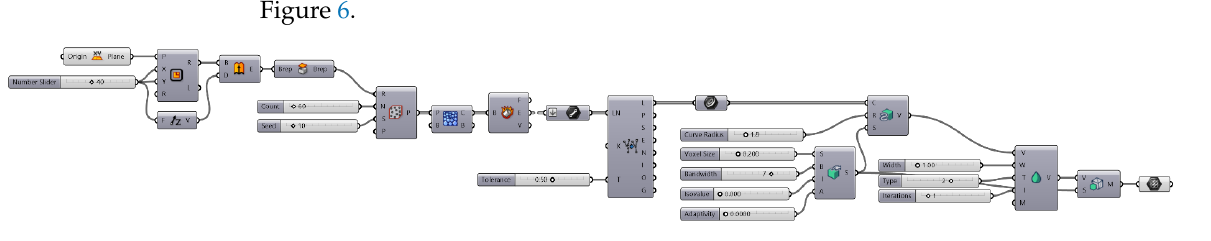
Figure 5. The Grasshopper definition on the visual programming environment’s canvas.